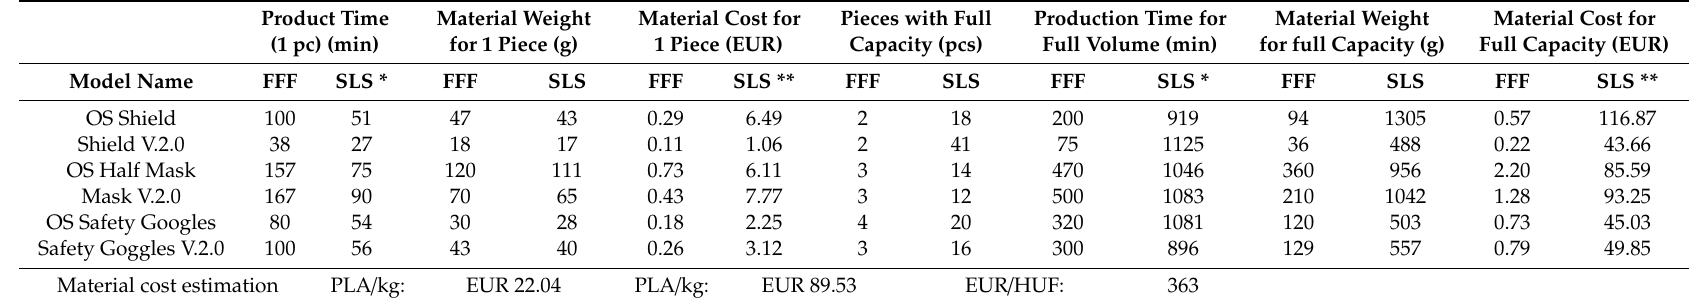
Table 1. Summary of production properties of PPE devices in case of fused filament fabrication (FFF) and selective laser sintering (SLS) 3D